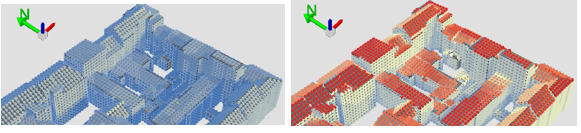
Figure 2. Visualization of global solar irradiation results for the months (left) January, and (right) July. Blue and red colours rep- resent low and high solar radiation values